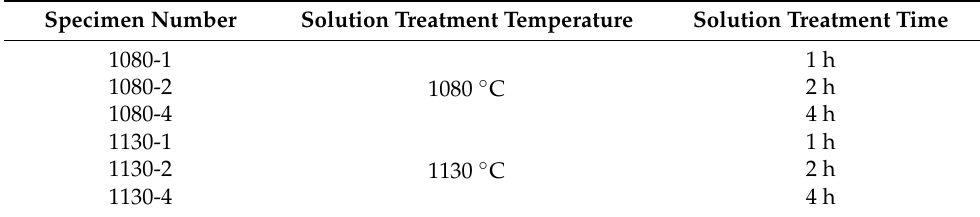
Table 2. Solution treatment